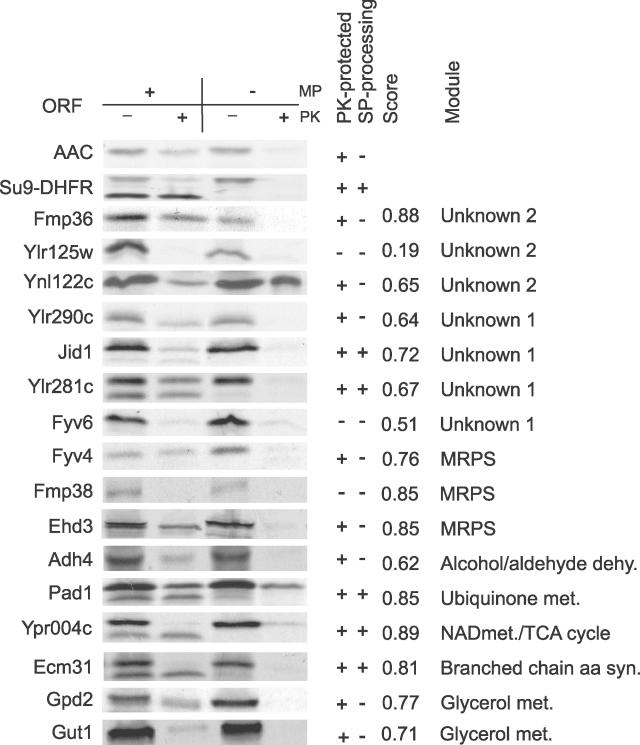
Verification of Predicted Mitochondrial Candidates by Mitochondrial ImportSamples were derived by incubating radiolabeled proteins with isolated mitochondria in the presence or absence of a membrane potential and of proteinase K. Cases where import was accompanied by removal of the signal peptide are marked as ‘‘SP-processing'' (+). Su9(1–69)DHFR and AAC serve as positive controls for a processed matrix protein and a non-processed inner membrane protein, respectively. The score reflects the likelihood of mitochondrial localization for tested candidates as predicted by the linear classifier. MP, membrane potential; PK, proteinase K; SP, signal peptide.